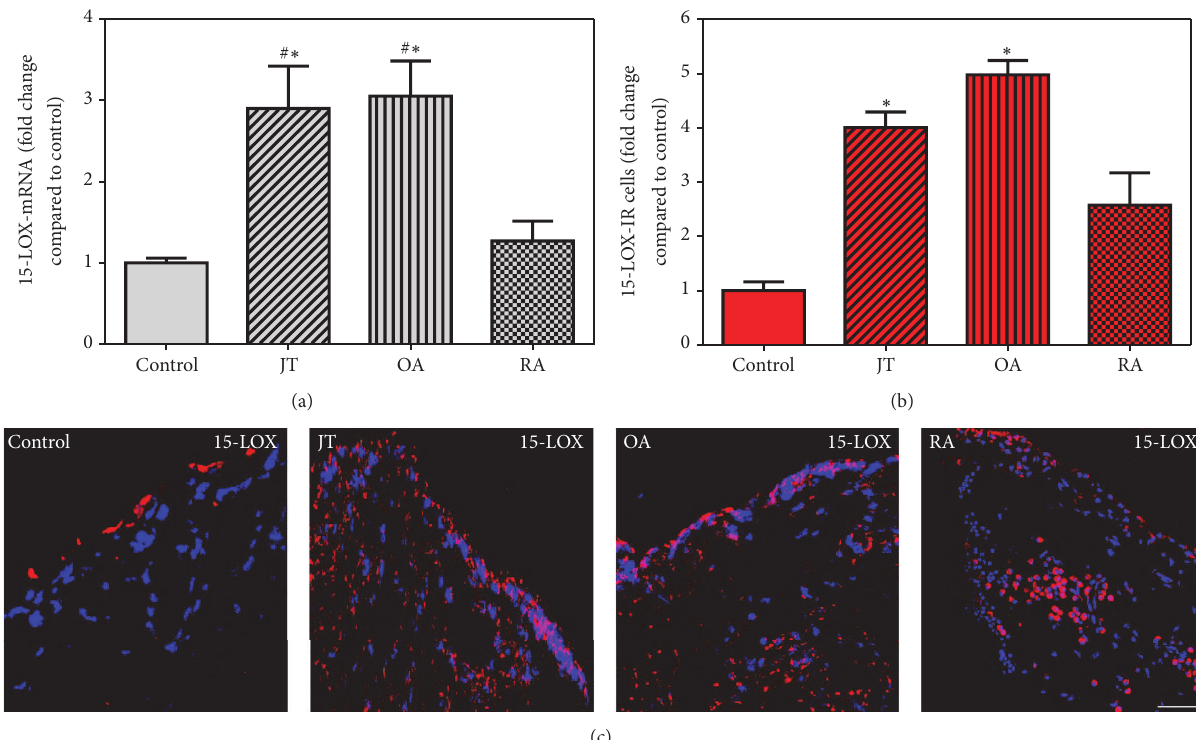
Figure 3: Detection of 15-LOX mRNA (a) and number of 15-LOX-IR cells (b and c) in patients with joint trauma (JT), osteoarthritis (OA), and rheumatoid arthritis (RA). (a) Quantification of 15-LOX mRNA shows that 5-LOX mRNA was significantly higher in OA and JT compared to RAand control synovium ( 𝑃 < 0.05 , one-way ANOVA followed by Tukey’s test). (b) Quantitative analysis of immunofluorescence microscopy for 15-LOX-IR cells. ∗ Relative to control, # relative to other groups ( 𝑃 < 0.05 , one-way ANOVA followed by Tukey’s test). Data are shown as means ± SEM. (c) 5-LOX-IR cells are more abundant in RA synovium than in JT, OA, and control synovium. Bar = 20 𝜇